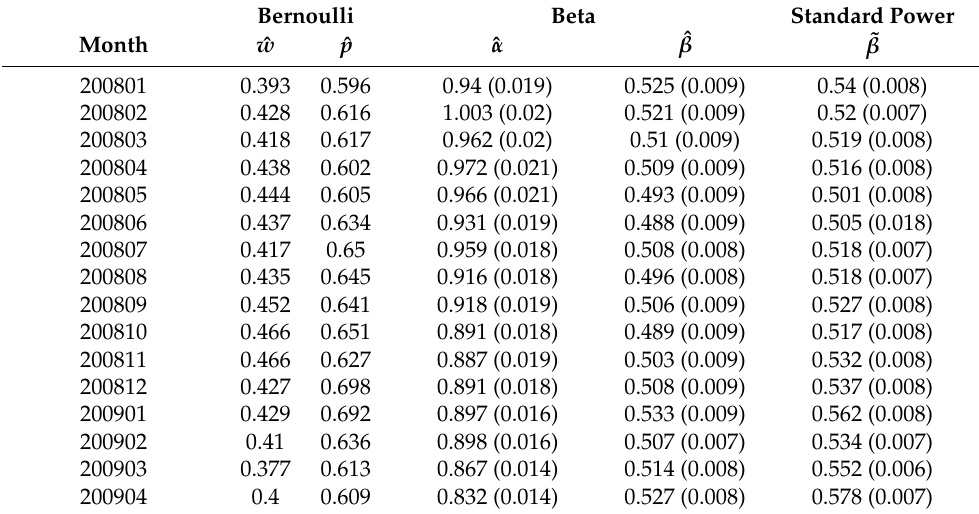
Table 2. Parameter estimates with estimated standard errors in parenthesis of the ZOIB and ZOISP models on rounded LGD